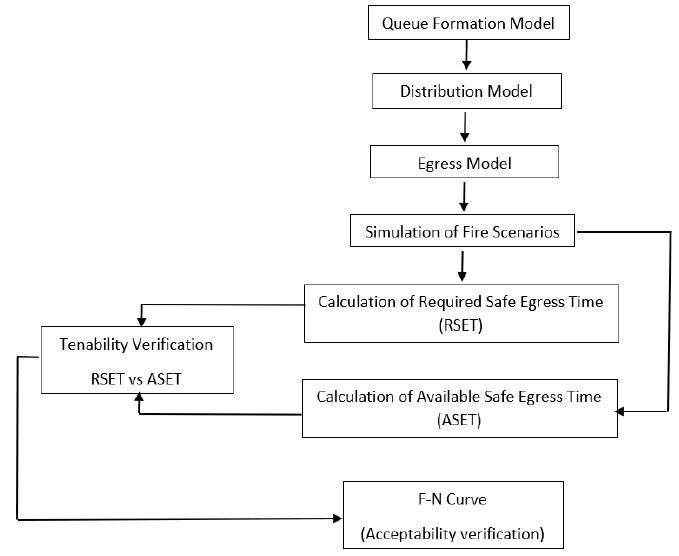
Figure 5. The process of quantitative consequence analysis model adopted from [2].